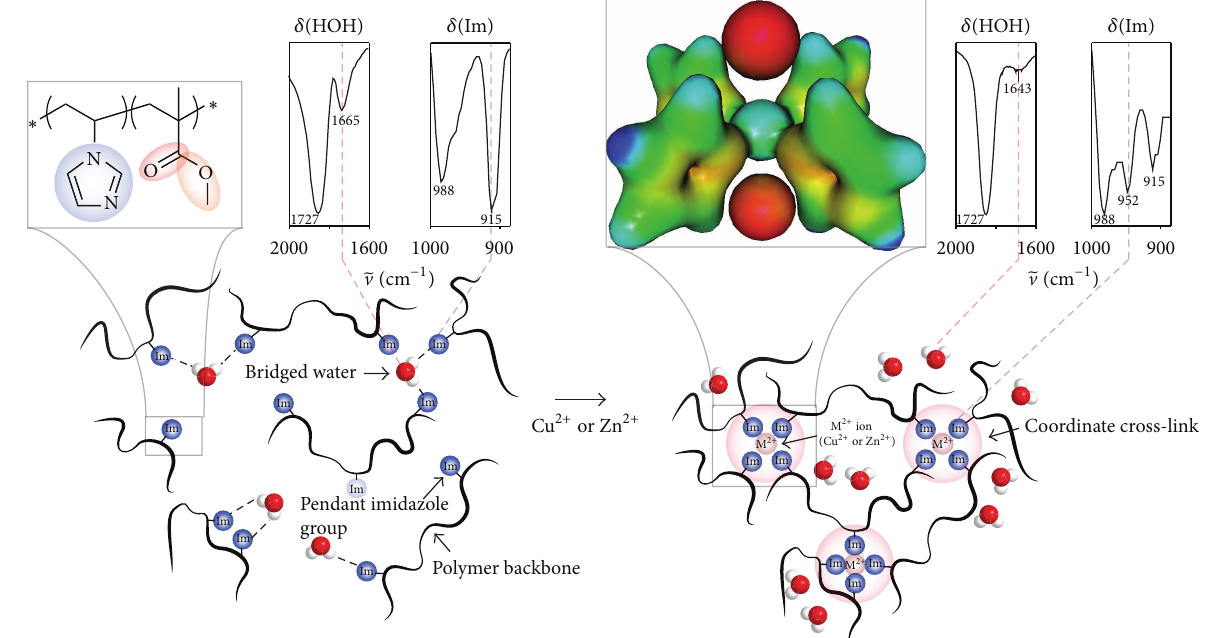
Figure 4: Schematic drawing of Im-H 2 O-Im bridged water and subsequent replacement by Cu 2+ or Zn 2+ , including the most important markers for H 2 O and Im, respectively, as well as the electrostatic potential energy surface of the [Cu(Im) 4 X 2 ] complex as obtained from ab initio calculations [39].